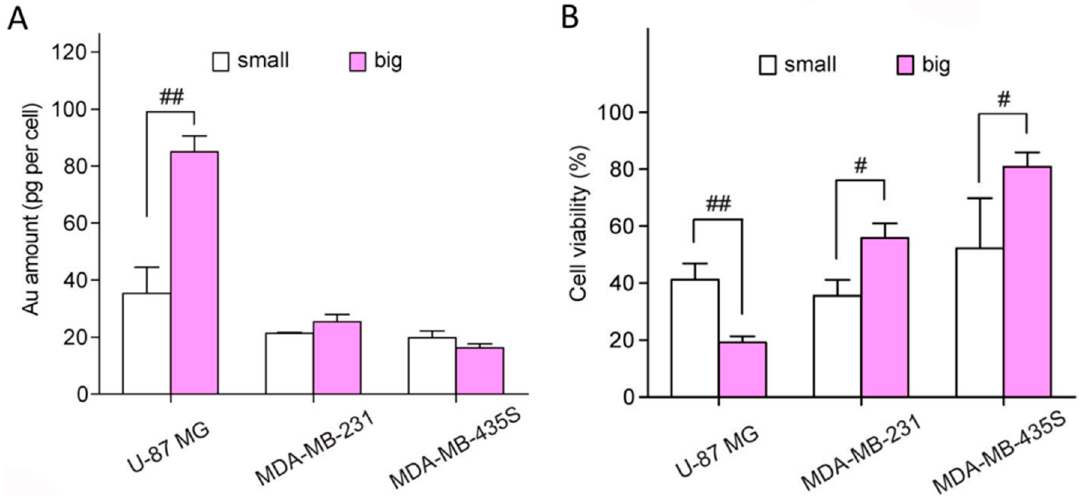
Figure 8. ( A ) Intracellular Au contents of the small (white) and large (pink) silica-coated Au nanorods samples in U-87 MG, MDA-MB-231, and MDA-MB-435S cells; and ( B ) cell viability upon photothermal therapy with small (white) and large (pink) silica-coated Au nanorod samples in U-87 MG, MDA-MB-231, and MDAMB-435S cells [38].